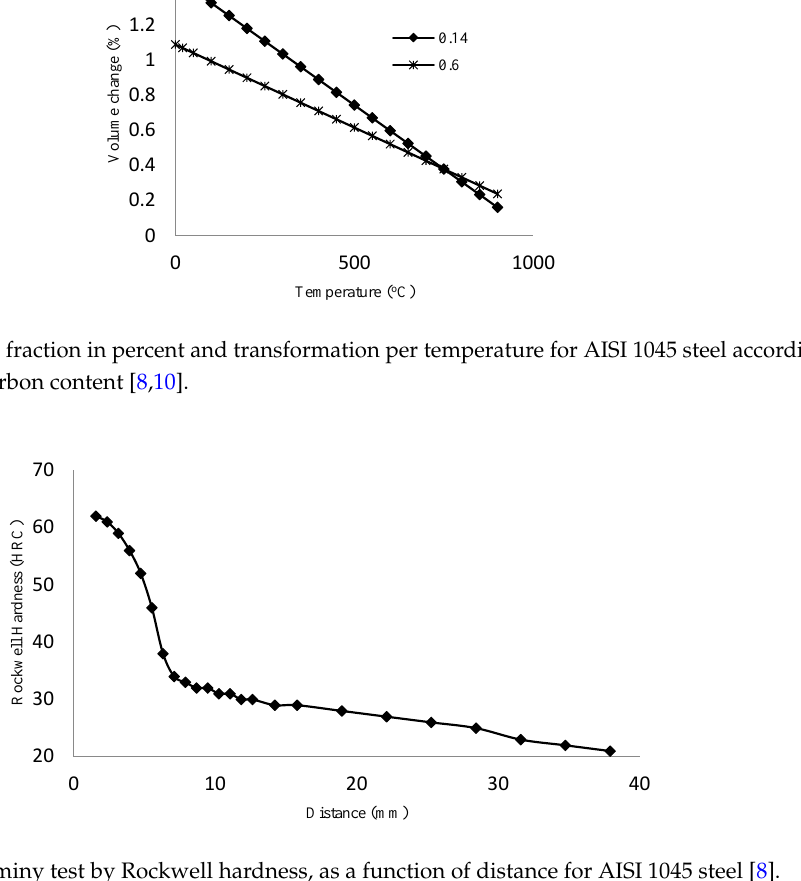
Figure 6. Jominy test by Rockwell hardness, as a function of distance for AISI 1045 steel [8].